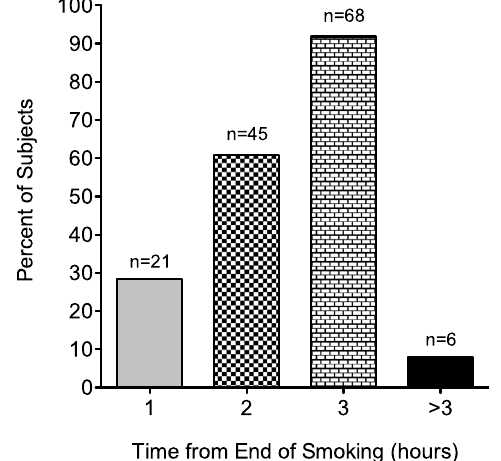
Figure 1. Impairment windows following cannabis smoking. The window of impairment after smoking cannabis was evaluated in 74 subjects who self-assessed their level of impairment prior to smoking and at various time points post-smoking using a 10-point